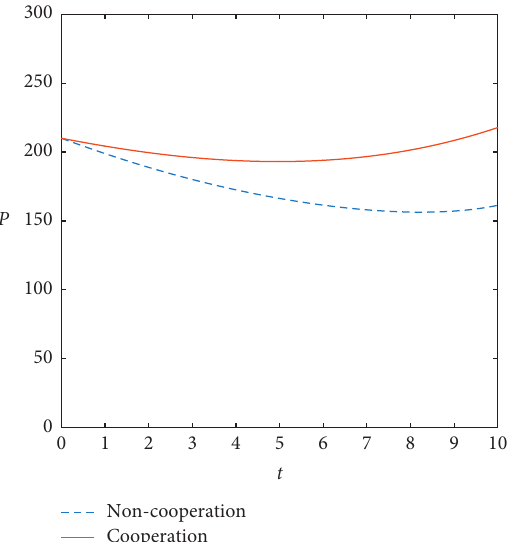
Figure 17: Optimal trajectory of pollution stock under cooperation when the planning period T ⟶ ∞ .